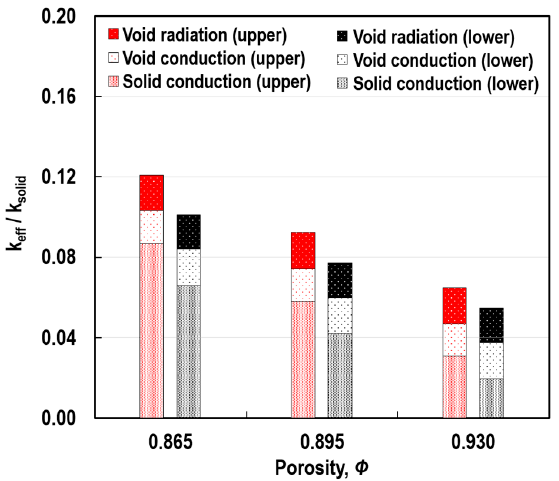
Figure 19. Variations in the k eff / k solid ratio and the individual contributions of the heat transfer modes according to Φ at L = 3 mm, δ cell = 258 μ m, and 𝑞(cid:4662) (cid:3036)(cid:3045)(cid:3045)(cid:4593)(cid:4593) = 50 kW/m 2 .